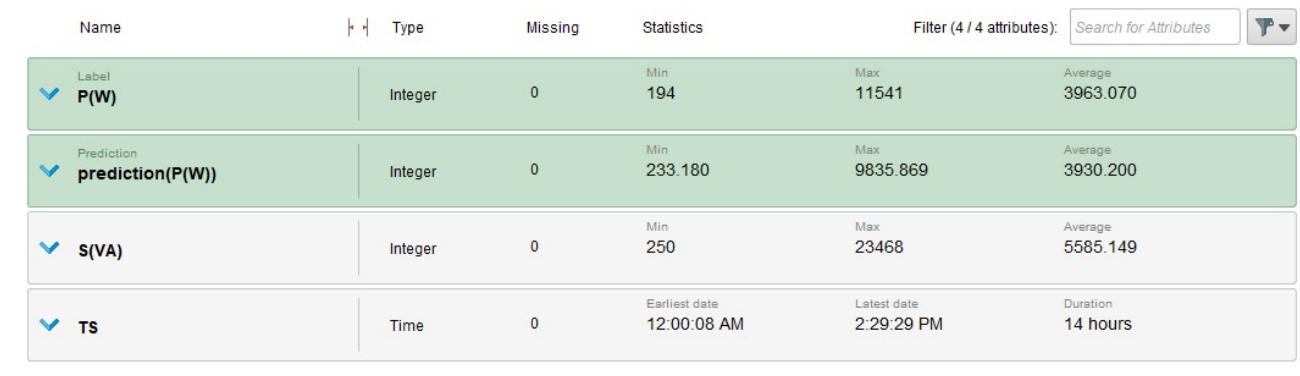
Figure 14. Statistical results of ANN model.